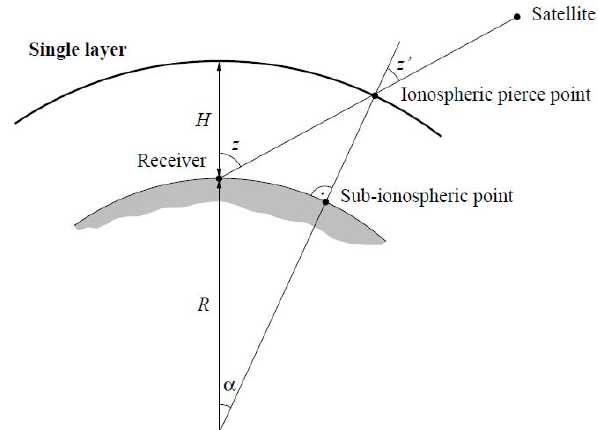
Fig. 2. Single-Layer Model (from Dach et al.,